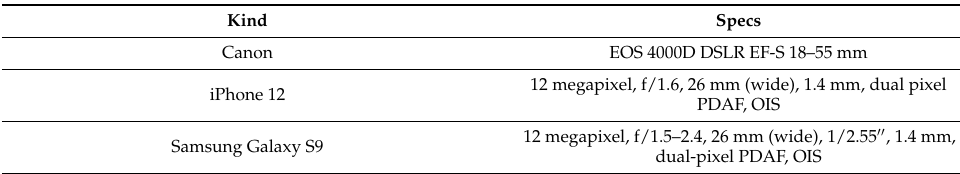
Table 2. Used cameras’